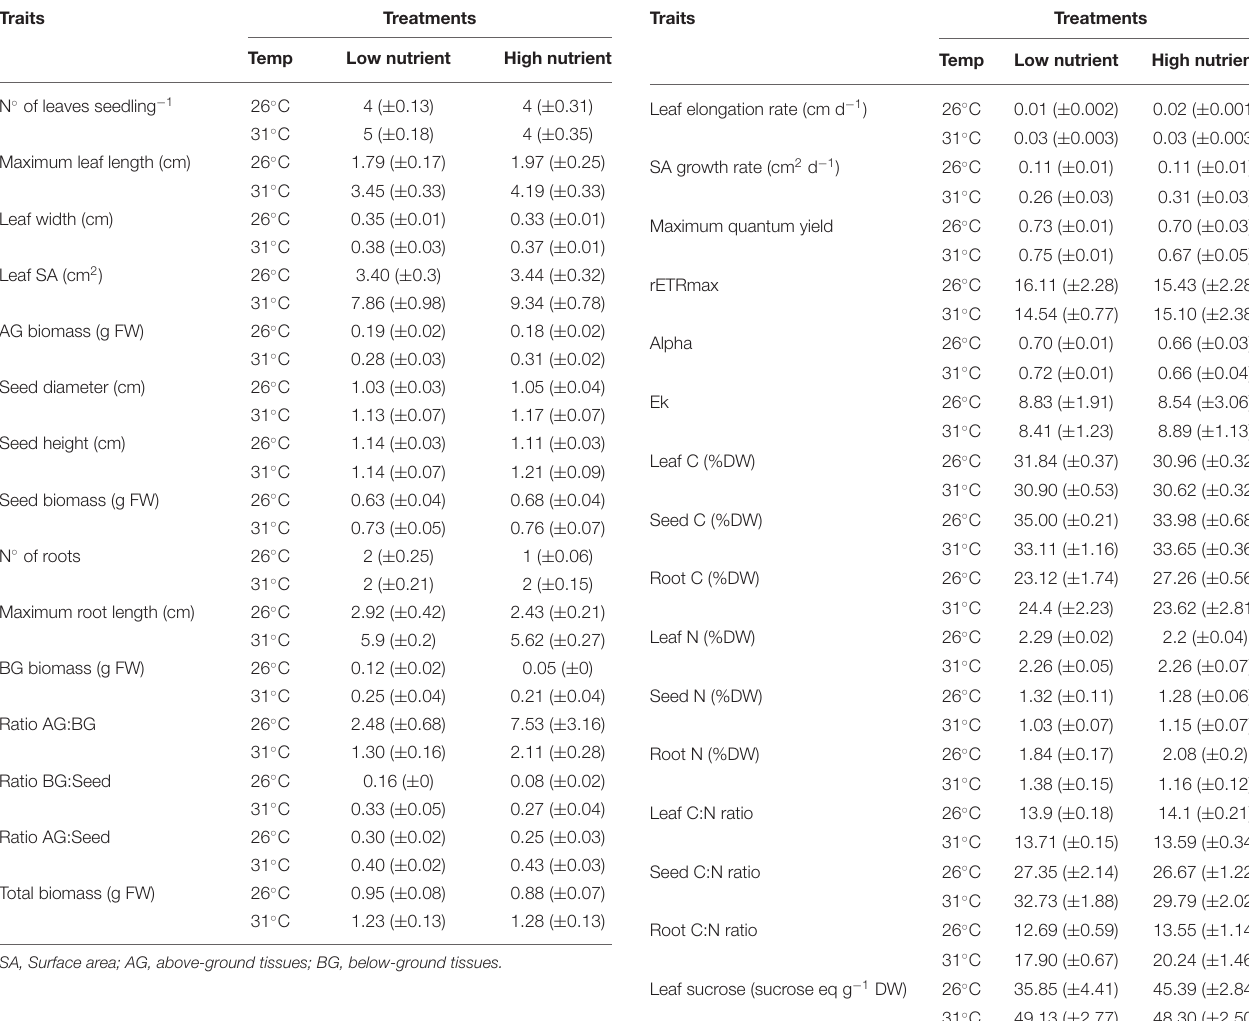
TABLE 3 | Biochemical and physiological traits (mean ± SE, n = 6) of Enhalus acoroides seedlings in the four different temperature (Temp) and nutrient treatments at the end of the